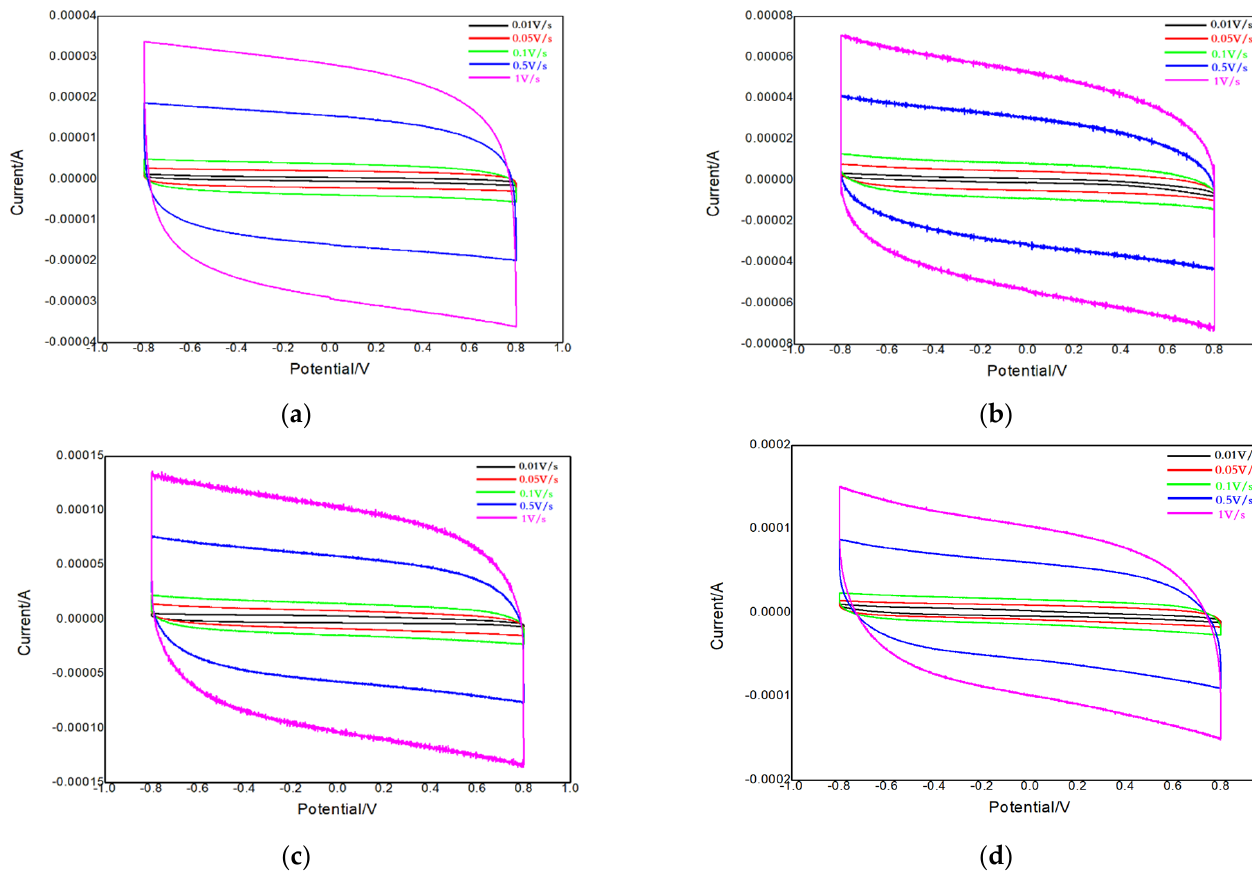
Figure 3. Cyclic voltammetry curves of the charred ZIF-67 ( a ), straw-ZIF-67 ( b ), ionic biochar-ZIF-67 ( c ), and pyrolytic biochar-ZIF-67 ( d ).